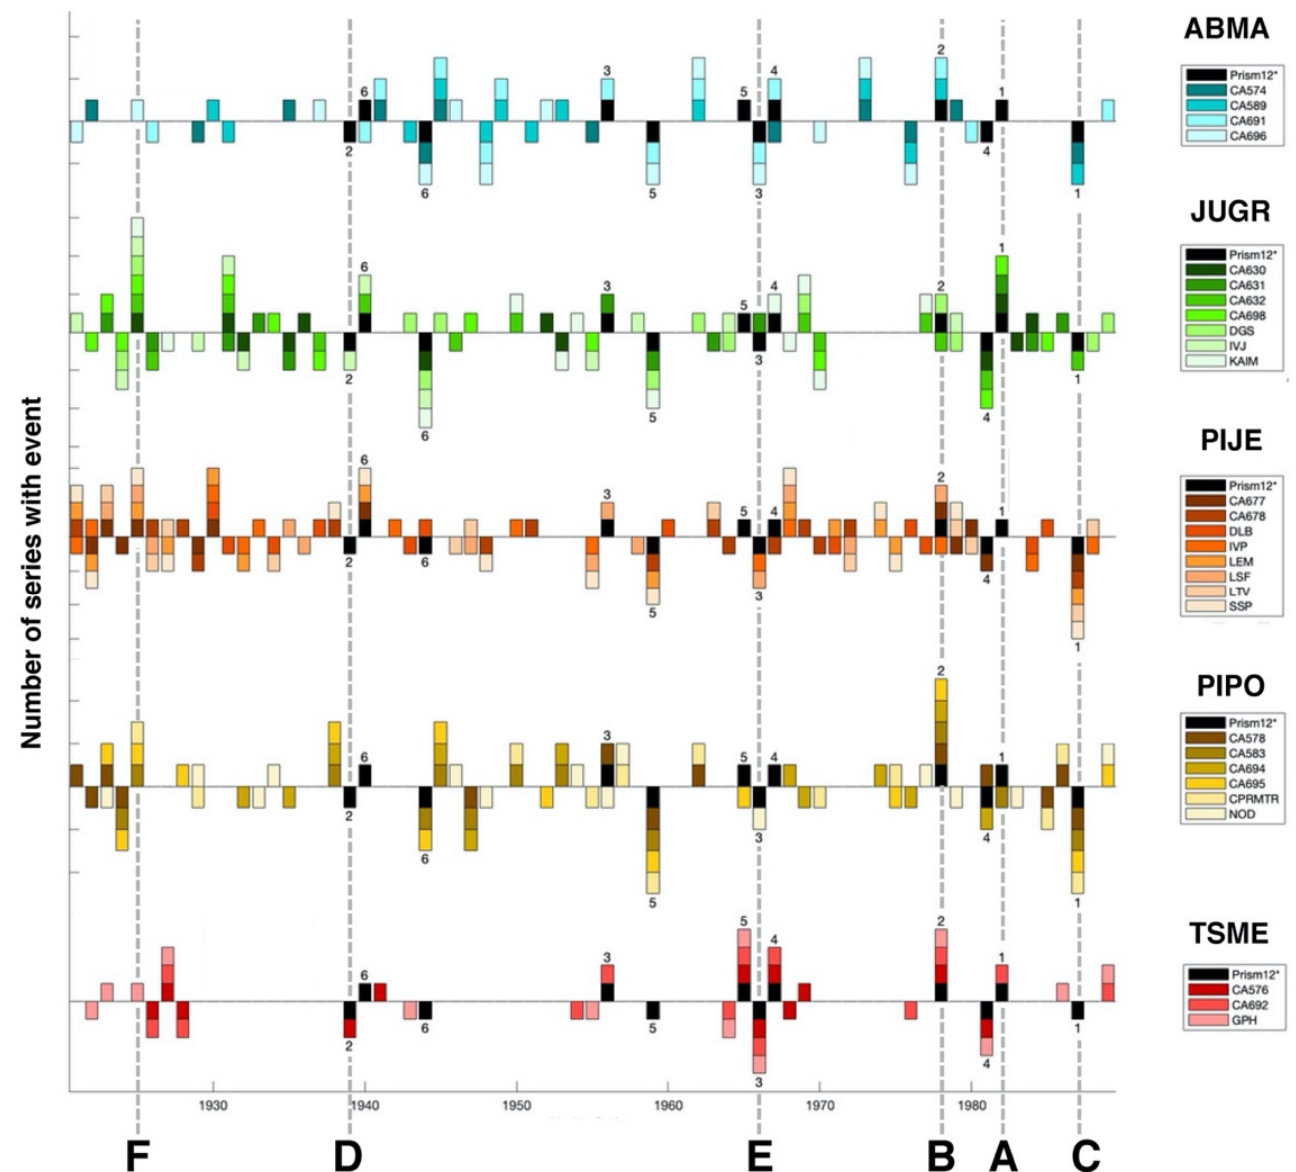
Figure 6. Whiplash events in observed P12 and in site-specific reconstructions grouped by tree species, 1921–1989. Plotting convention as in Figure 3. Numbers above and below bars are ranks of positive and negative P12 events as defined in text. Color codes identify the chronologies of the five species (see Table 1). Labeled years (A – F) are examined in more detail in Section 3.2.